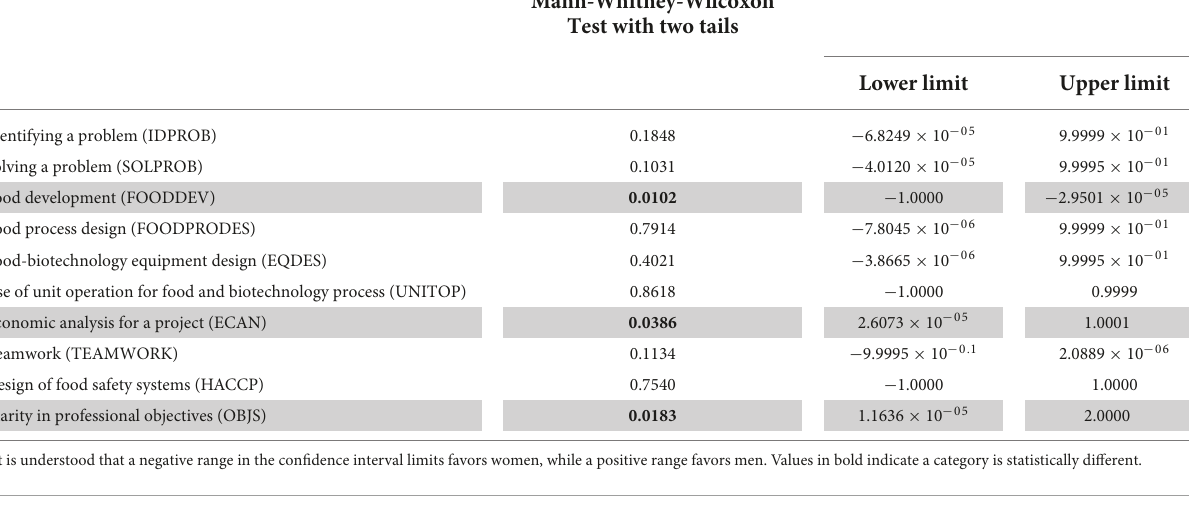
TABLE 1 Non-parametric Mann-Whitney-Wilcoxon hypothesis test of mean difference by self-evaluation category and gender a 95% confidence level and two tails a . Self-evaluated category P -value obtained in the